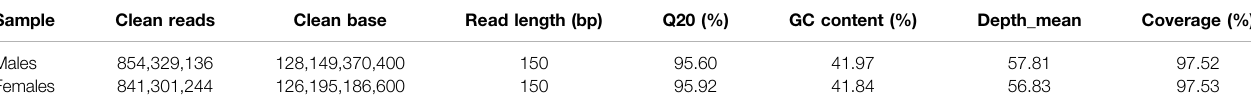
TABLE 2 | Statistics results of the reads of whole-genome resequencing.